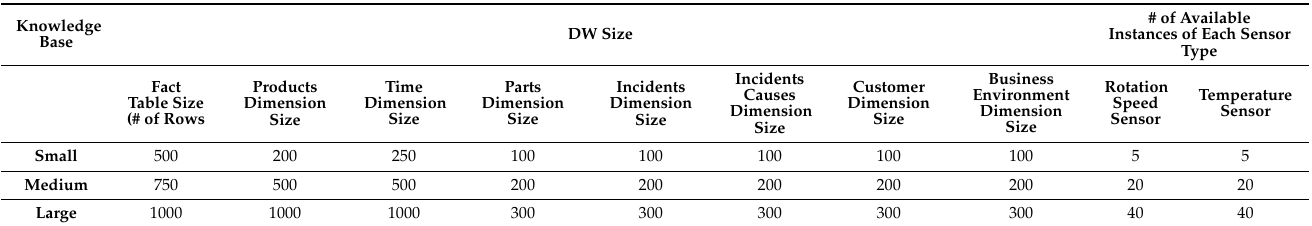
Table 6. Description of the three knowledge bases used for performance evaluation.